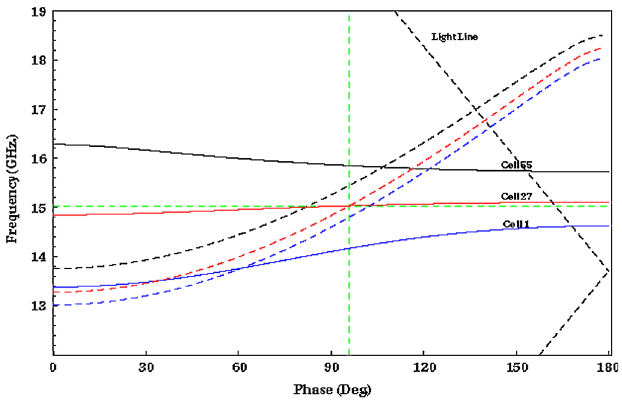
FIG. 8. (Color) Mode coupling parameters versus cell number for H60VG3. Here fs indicates the location of the intersection of the light line with the cell mode and fx the intersection of the manifold and cell mode. Also, f 0 and fpi indicate the location of the 0 (cid:2) and 180 (cid:2) point in the cell